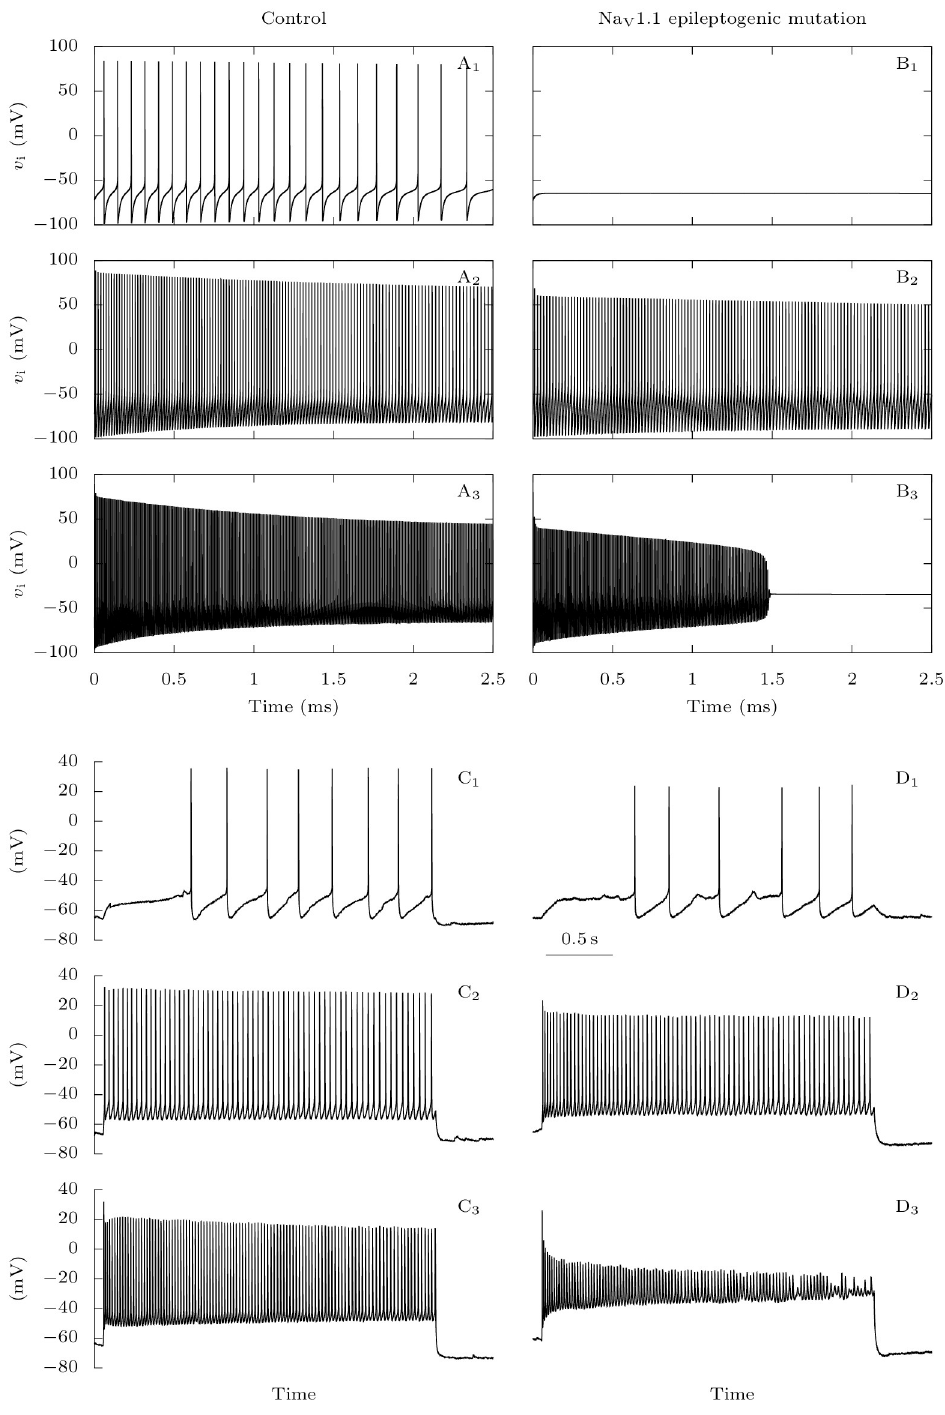
Fig 9. Effect of Na V 1.1 epileptogenic mutations on the firing of GABAergic neurons: Representative traces. A-B : Model simulations. We depolarized the GABAergic neuron at rest with constant excitatory conductances g D,i = 0.0075 ( A 1 , B 1 ), g D,i = 0.05 ( A 2 , B 2 ) or g D,i = 0.5 mS � cm − 2 ( A 3 , B 3 ), for the default parameters ( A : control condition), or when the sodium fast-inactivating maximal conductance is reduced to 40% of its default value ( B : Na V 1.1 epileptogenic mutation). C-D : Experimental data. Action potential discharges elicited in a fast spiking GABAergic layer 2-3 cortical neuron from a wild type mouse ( C ) or a Scn1a +/- mouse ( D ), injecting depolarizing current steps of 10 pA ( C 1 ,D 1 ), 100 pA ( C 2 ,D 2 ) or 260 pA ( C 3 ,D 3 ).